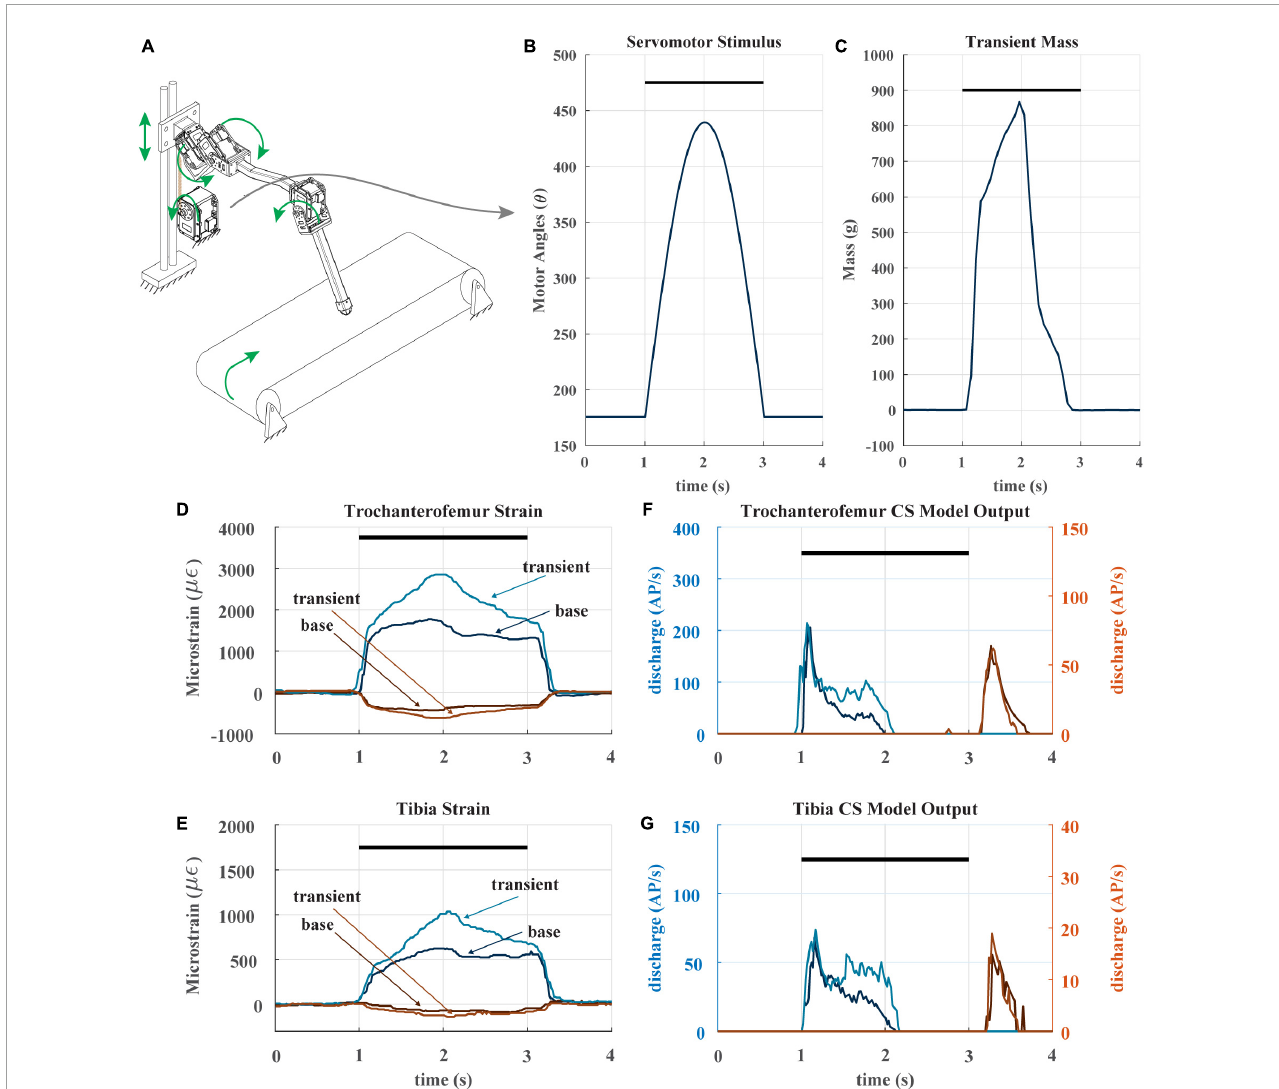
FIGURE7 (A) Diagram of robotic leg configuration. Green arrows show type and direction of movement for the leg servomotors, perturbation servomotor, linear guide, and treadmill. The perturbation servomotor can apply a controlled load to the linear guide. (B) The applied angle positions of the perturbation servomotor. Black bar indicates stance phase (C) resulting transient mass to linear carriage from perturbation servomotor. (D) The raw trochanterofemur strain of individual steps in the baseline and perturbation configuration. Positive changes in values indicate compression in that direction; negative changes in values indicate tension in that direction. Black bar indicates stance phase. (E) The raw tibia strain of individual steps in the baseline and perturbation configuration. (F) The model CS outputs (group 3 and 4) of the trochanterofemur baseline and perturbation steps. (G) The model tibia CS (group 6B and 6A) outputs of the baseline and perturbation